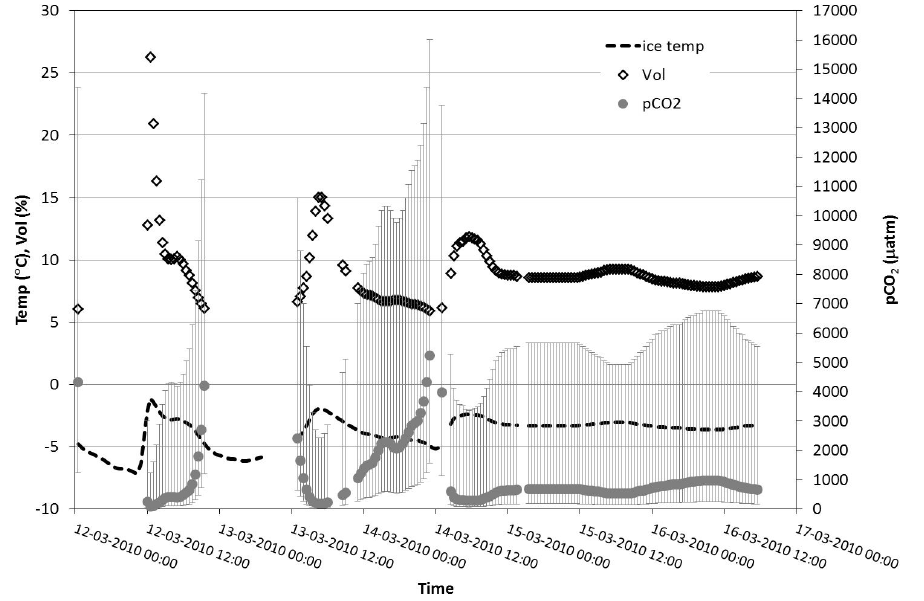
Fig. 5. Measured ice surface temperature ( ◦ C) and calculated brine volumes (%) and p CO 2 (µatm) in the brine channels from 12 to 16 March. The error bars around the p CO 2 are based on maximum and minimum values using the standard deviation on the measured salinity, TCO 2 and TA (see Table